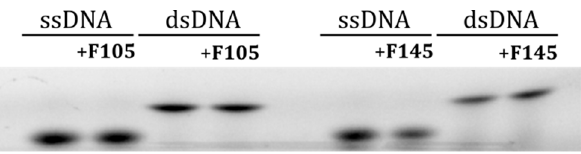
Figure 7. The electrophoretic mobility shift assay (EMSA) of 2(5 H )-furanone derivative interactions with single- and double-stranded DNA.